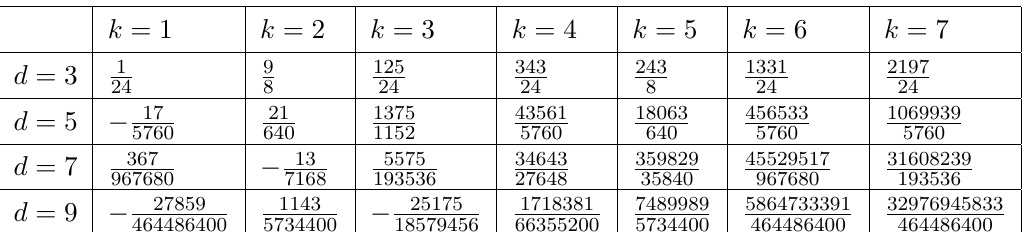
(cid:12) for scalars with 4 Table 2 . ∆ F ∂ (cid:12) log boundary scalar mass deformation ( q = 0